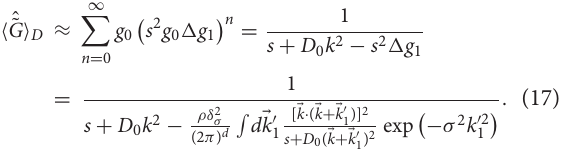
D n ( E k ) within the Fourier-Laplace transformed Green’s function hˆ˜ G ( E k h i D D 2 , and the diagrams in (B) identify the selection rules for h i D